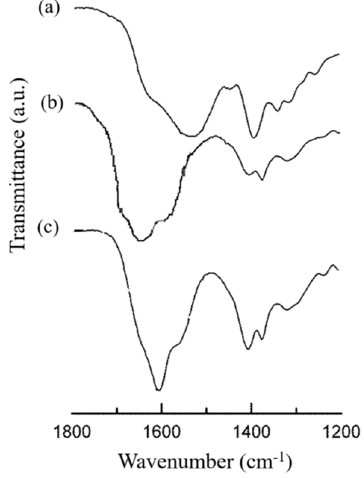
Figure 2. FTIR spectra of (a) CS (raw material), (b) HA/CS-TPP NPs, and (c) HA (raw material).